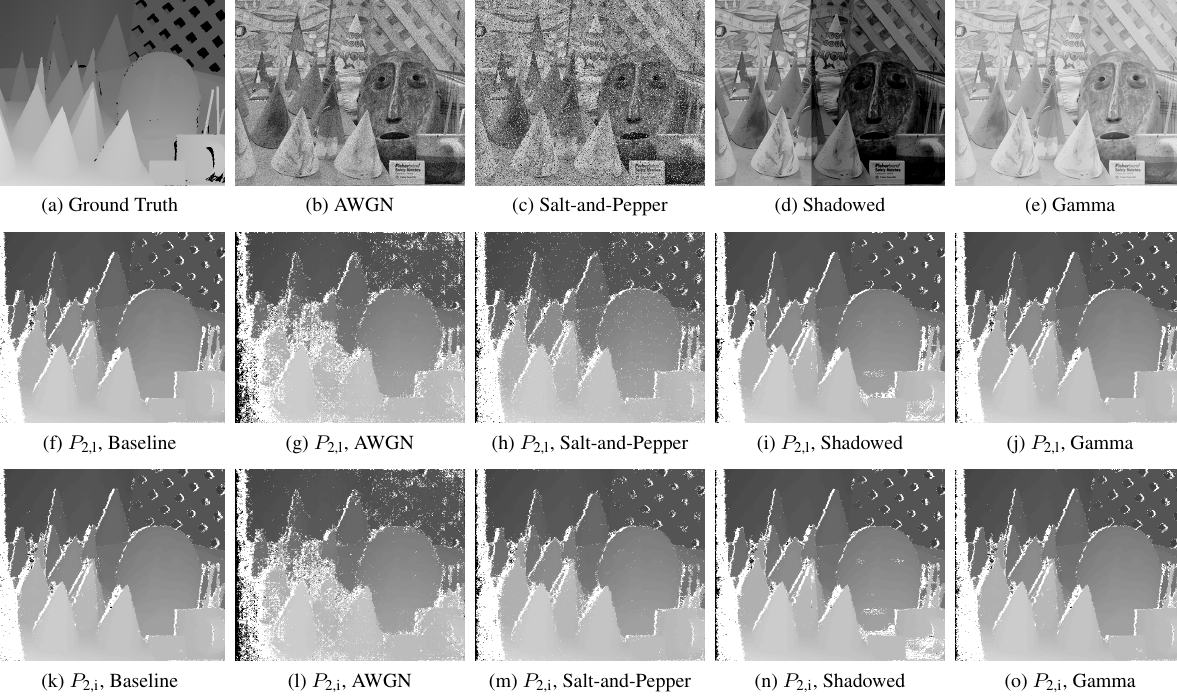
Figure 8: Degenerated input images (row one) and corresponding disparity maps obtained with P 2,l (row two) and P 2,i (row three) using the census